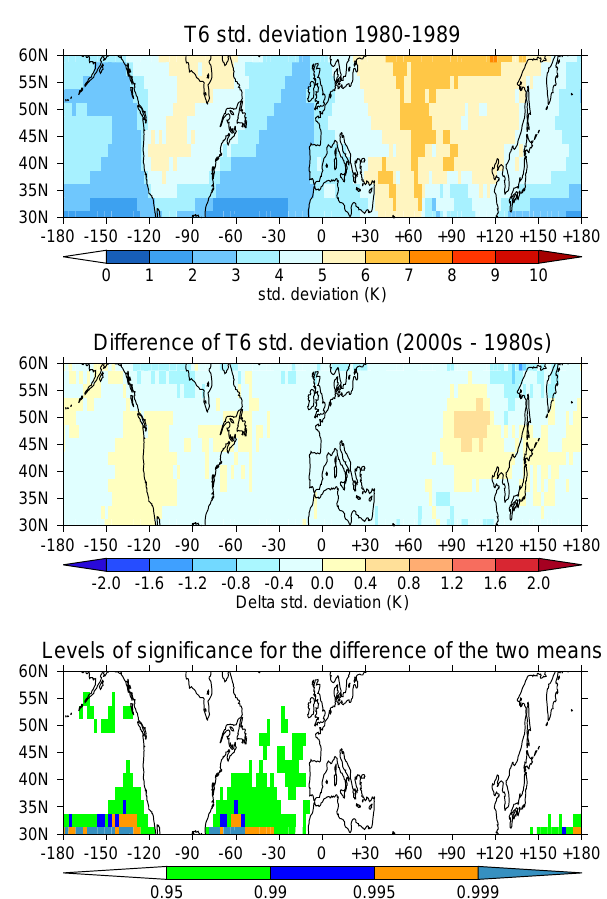
Fig. 7. As figure 5, but for T 6 . Figure 7. As Fig. 5, but for T 6 .